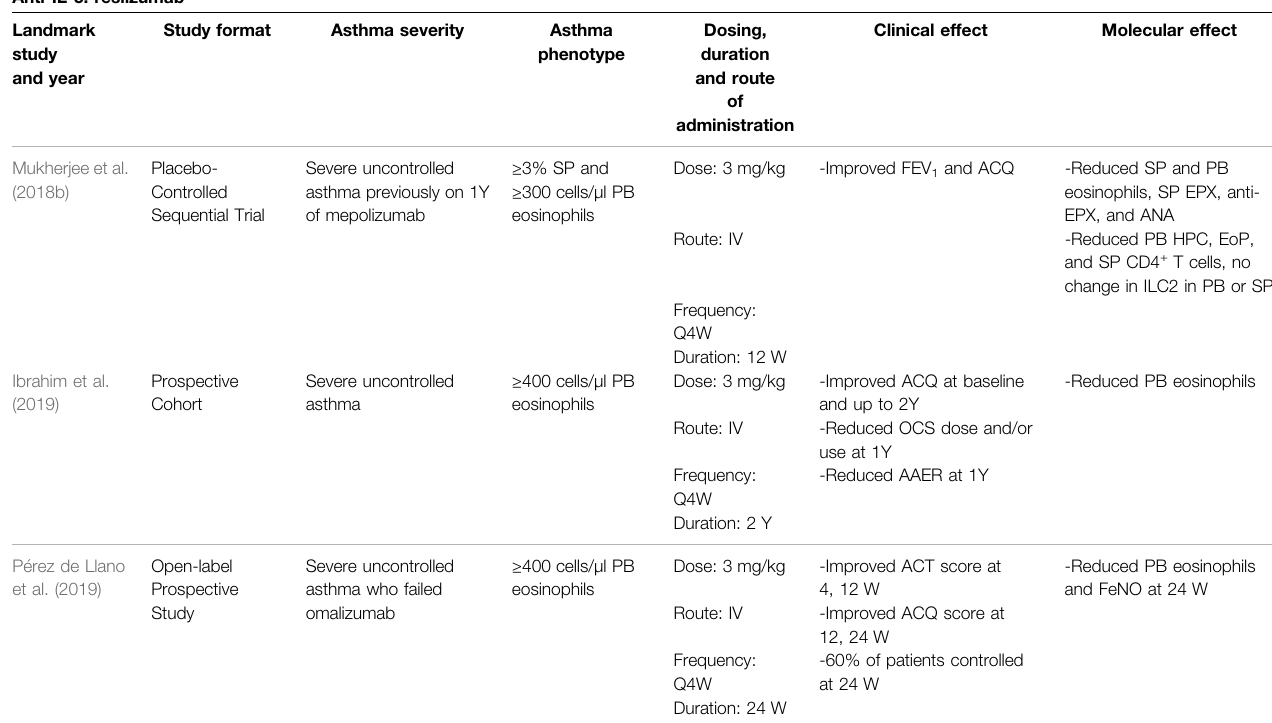
TABLE 3 | ( Continued ) Summary of randomized clinical trials assessing reslizumab in severe